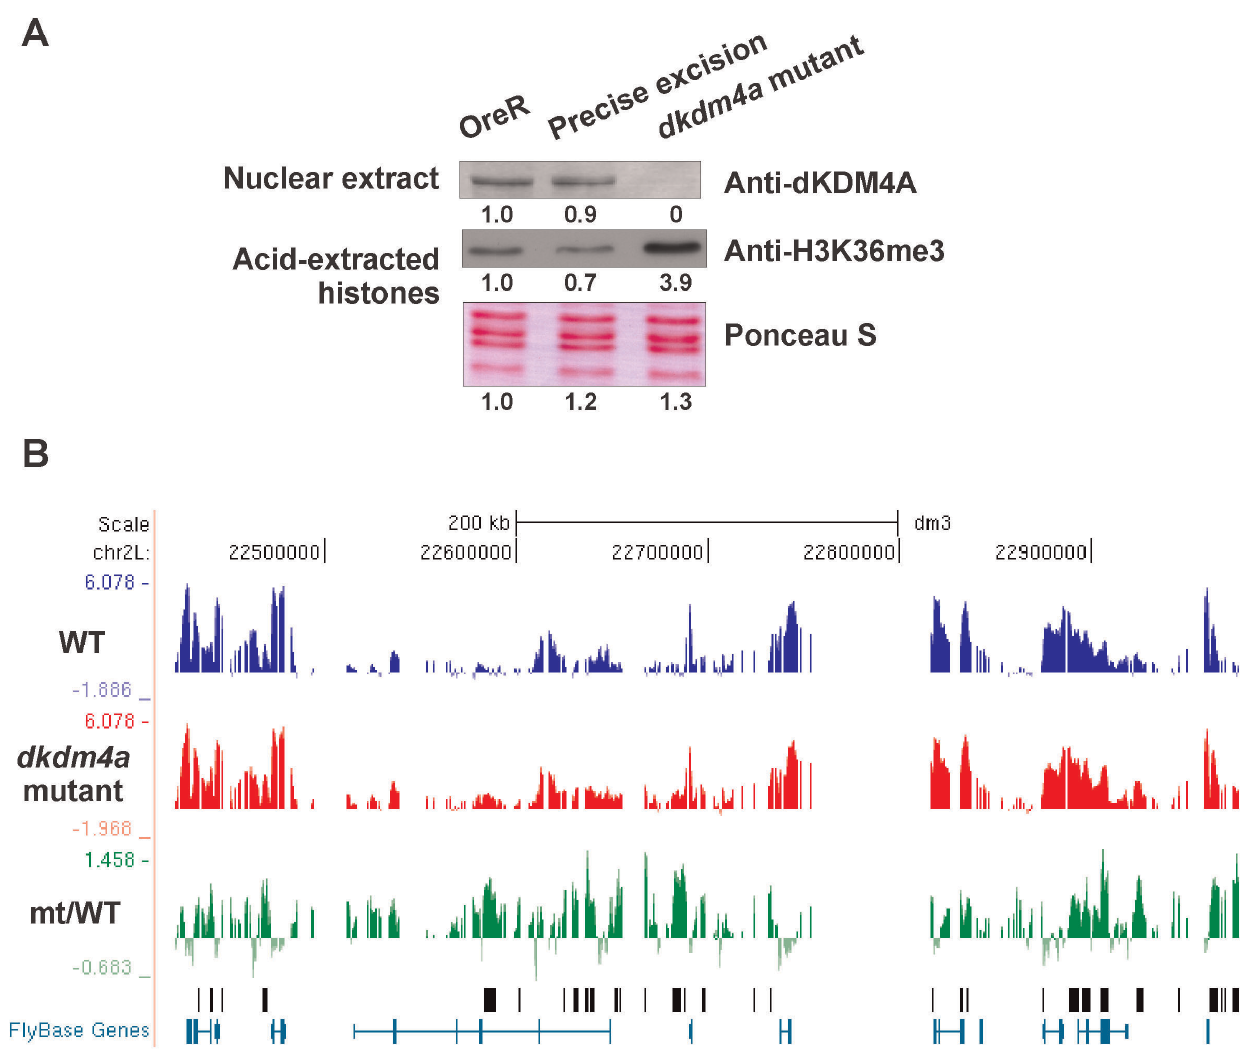
Figure 1. Identification of dKDM4A targets by H3K36me3 ChIP-chip analysis. (A) P-element insertion abrogates the expression of dKDM4A and results in increased levels of bulk histone H3K36me3. Precise excision of P-element restores the expression level of dKDM4A and the bulk level of H3K36me3. Nuclear extracts and acid-extracted histones from embryos of OreR, dkdm4a mutant and precise excision rescued fly lines were analyzed by western blot using indicated antibodies. Quantitation of the signal intensity is shown below each blot. (B) H3K36me3 profiles of chromosome 2 Lh genes. H3K36me3 ChIP-chip results are displayed on the UCSC genome browser for one representative biological replicate. The profile of H3K36me3 ChIP-chip in wild type embryos is shown in blue and the profile in dkdm4a mutant embryos is shown in red. The profile of increased H3K36me3 levels (mt/WT) is shown in green. Peaks called on the ratio track (mt/WT) are marked with black bars. y-axis shows log2 intensity ratio values; x-axis shows protein-coding genes annotated by